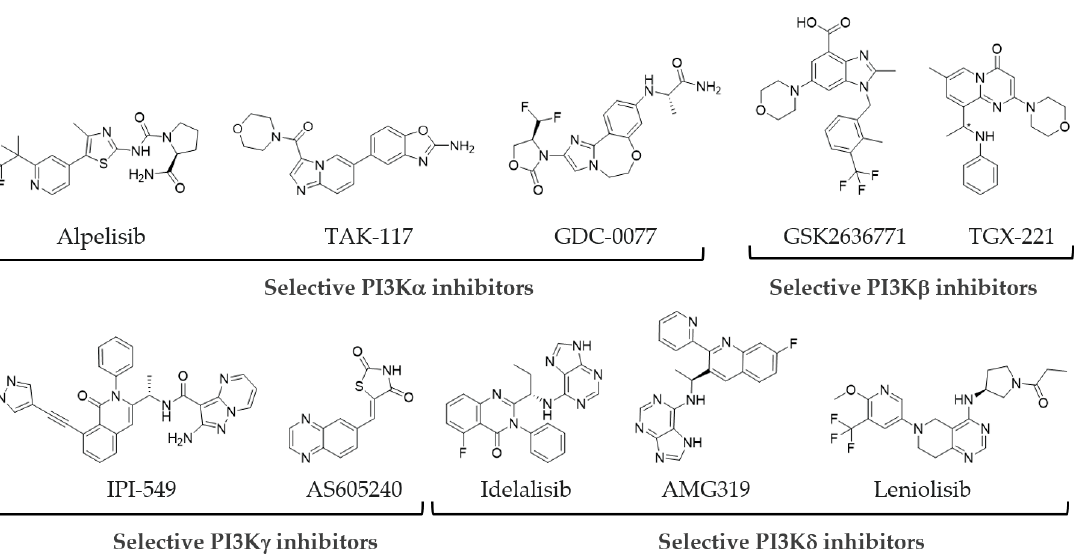
Figure 2. Examples of isoform-speci fi c PI3K inhibitors approved for clinical use or under clinical development [19–24].